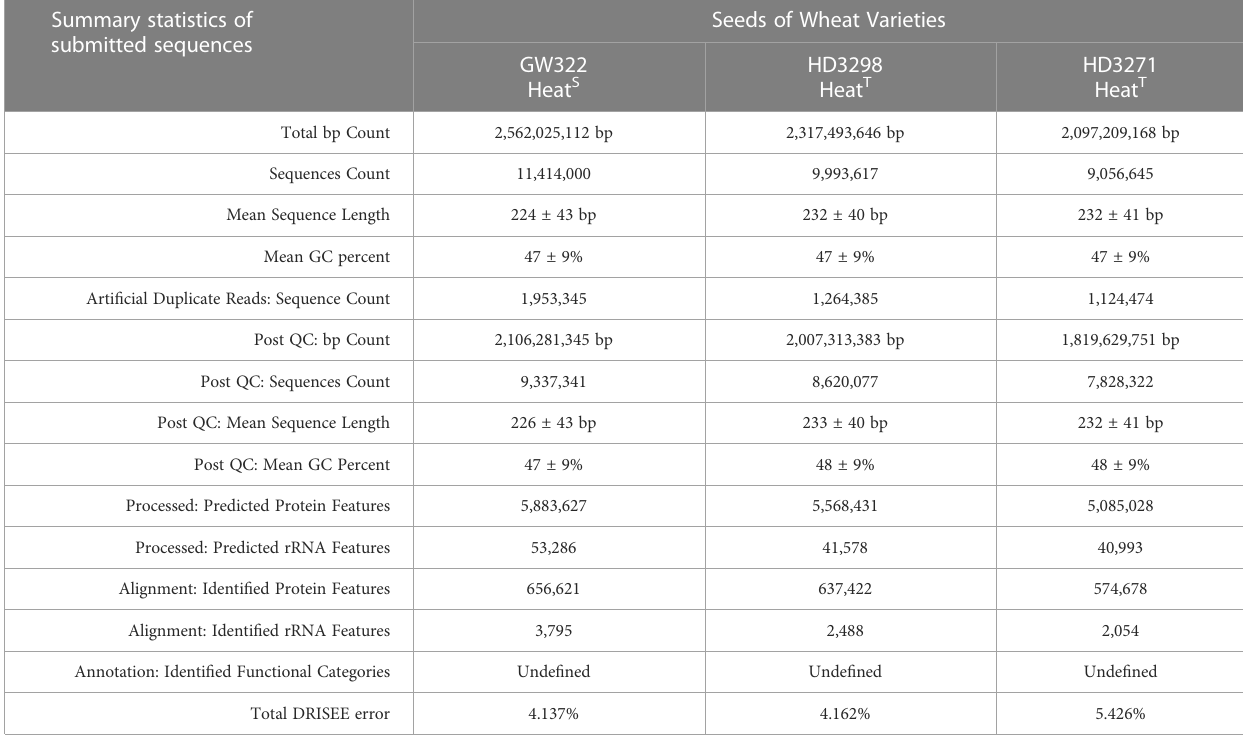
TABLE 2 Statistics of metagenome sequences for MG – RAST analysis